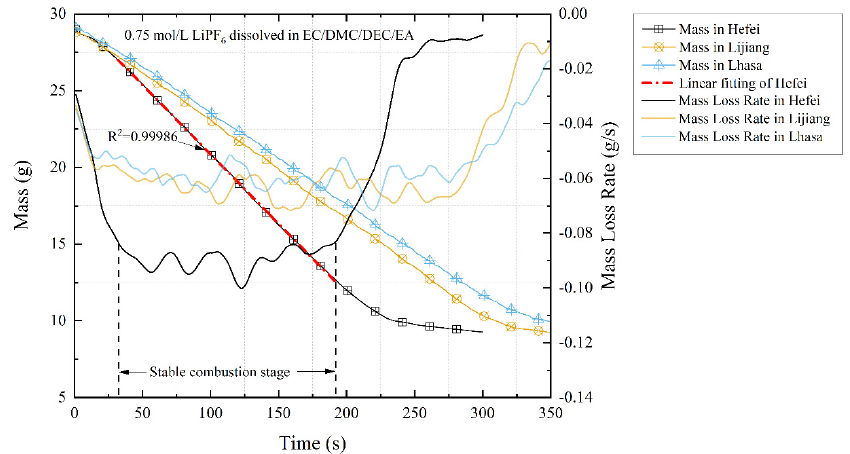
Figure 7. Changing mass and mass loss rate (MLR) curves of the electrolyte with LiPF 6 at different altitudes: mass in Hefei (black square), mass in Lijiang (yellow circle), mass in Lhasa (blue triangle), linear fitting mass of Hefei (red dotted line), MLR in Hefei (black line), MLR in Lijiang (yellow line) and MLR in Lhasa (blue line).